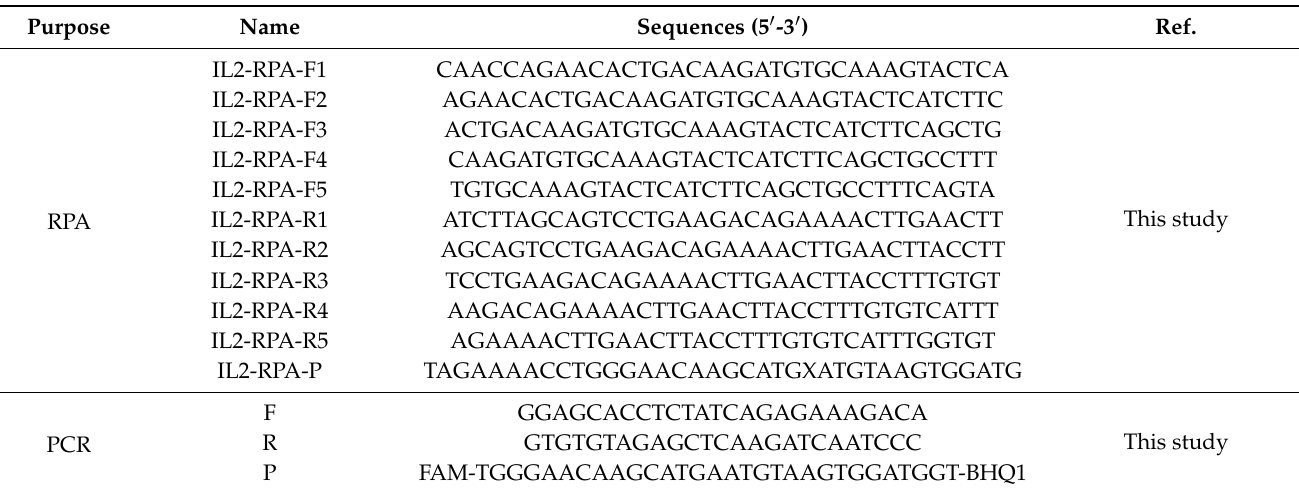
Table 3. Sequences of Primers and